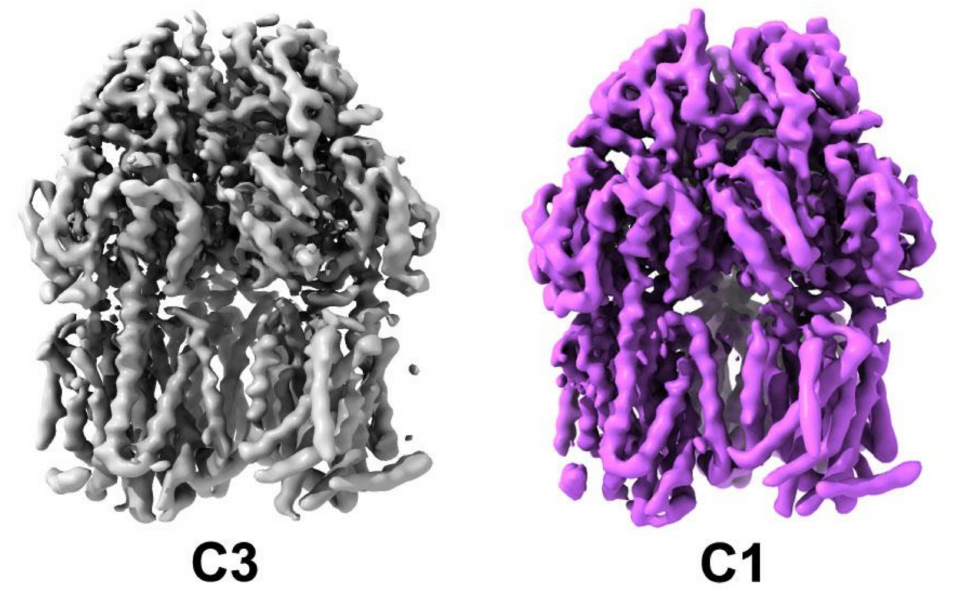
Figure 3. Comparison of S TmAcrB G288D cryo-EM maps refined in C3 and C1 with no di ff erence in the overall architecture observed but slightly improved resolution in the C3